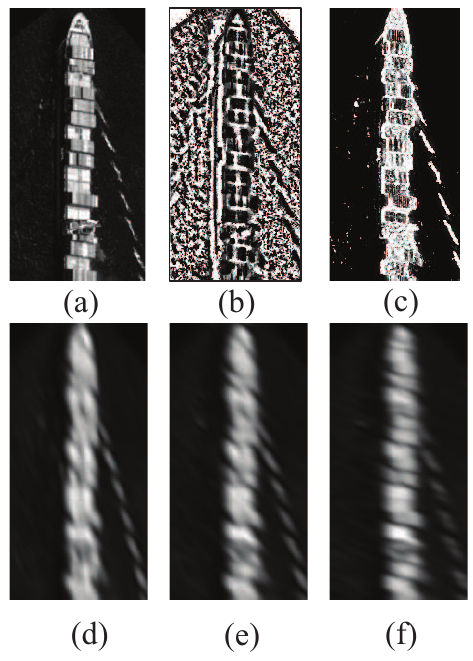
Figure 5. DisplayofGaborfilter andCLBPimages. ( a )originalimage. ( b )CLBP_Scodedimage. ( c )CLBP_M coded image. ( d – f ) represent filtered images obtained by using Gabor filter with different